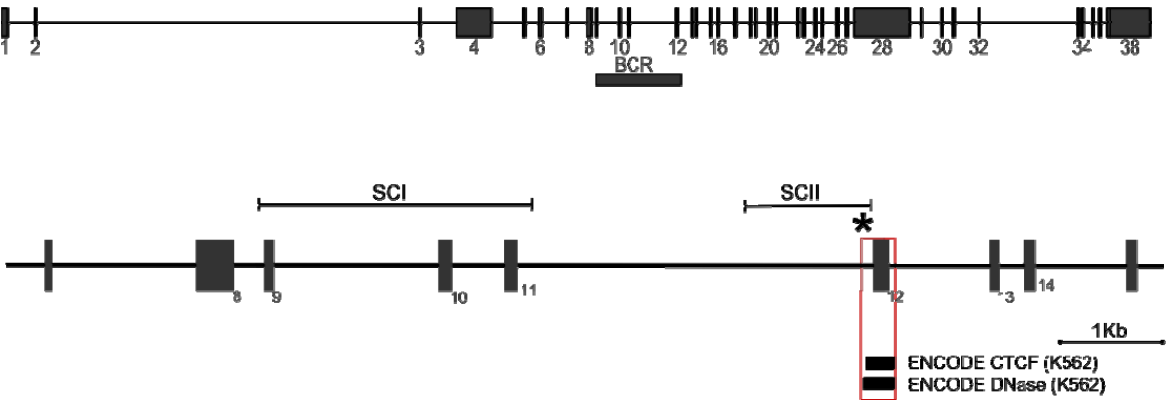
Figure 4. MLL translocations. Top: Genomic organization of the MLL gene, exons are numbered. Horizontal rectangle, breakpoint cluster region (BCR). Bottom: Enlarged segment of the MLL locus encompassing the breakpoint region. SCI and SCII denote BCR subclusters in which de novo AML and t-AL/neonatal translocation breakpoints are concentrated respectively [45]. The asterisk denotes a “hotspot” where nine tightly clustered therapy related or neonatal breakpoints have been reported. The red-boxed region highlights a peak of CTCF binding and DNase I hypersensitivity observed in the publically available ENCODE data (http://genome.ucsc.edu/cgi-bin/hgGatewa